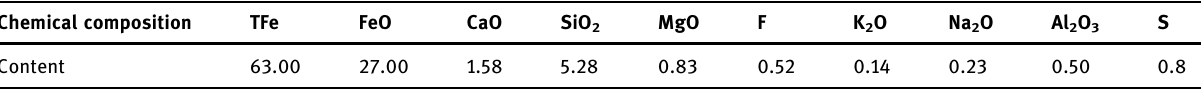
Table 1: Chemical composition of Bayan Obo iron concentrate ( wt% ) Chemical composition